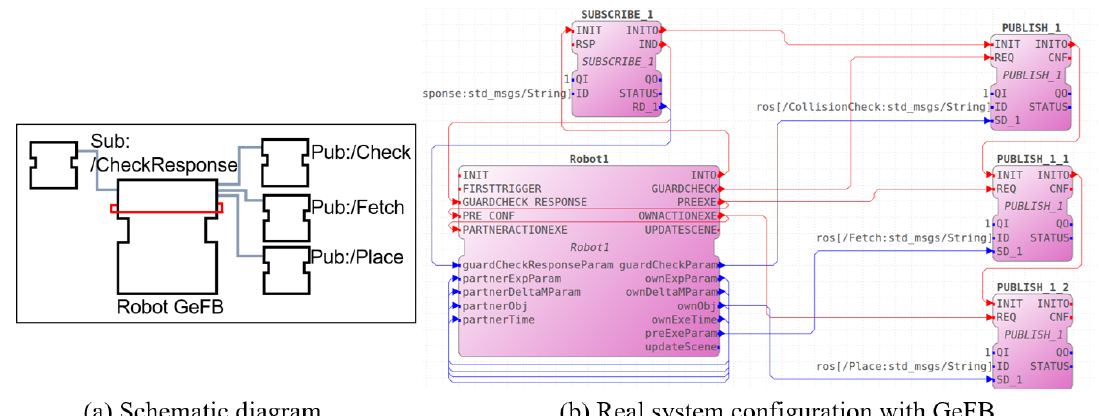
Figure 5. The application for one robot assembly line.